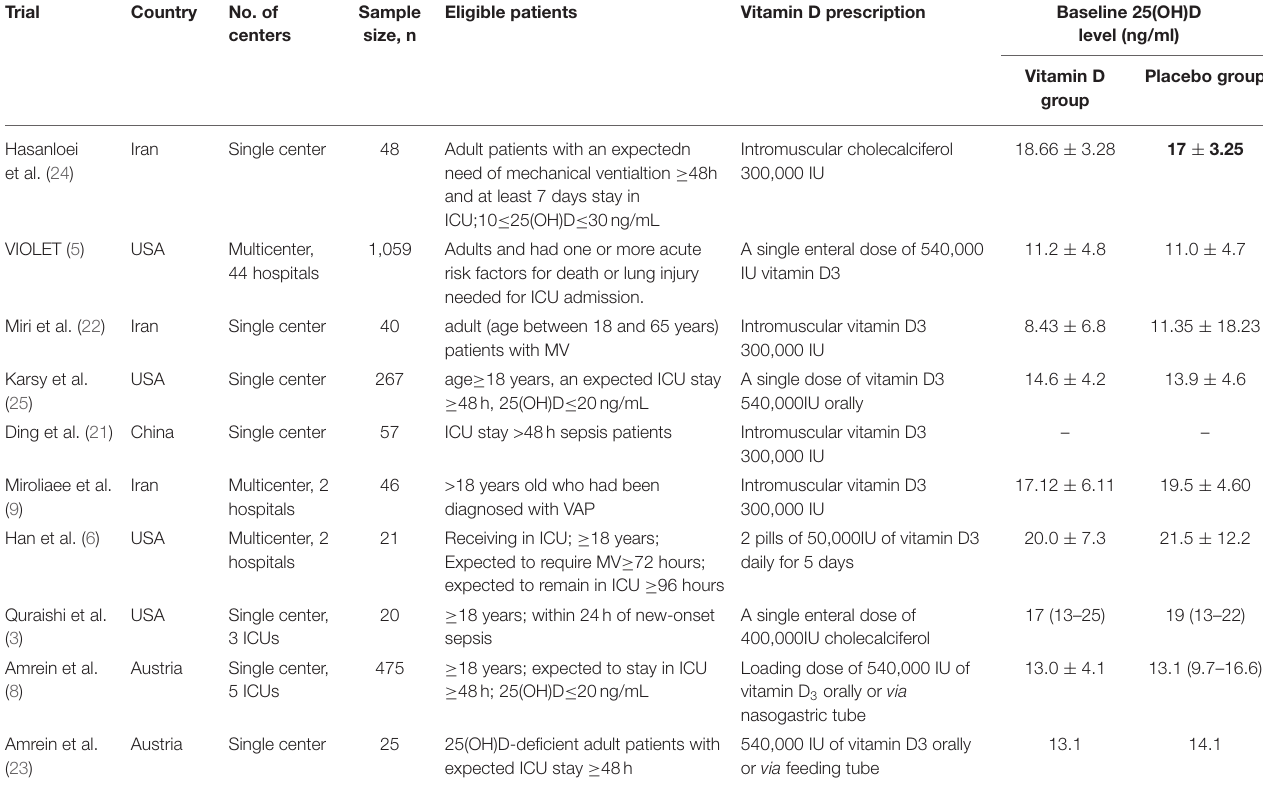
TABLE 1 | Baseline characteristics of included